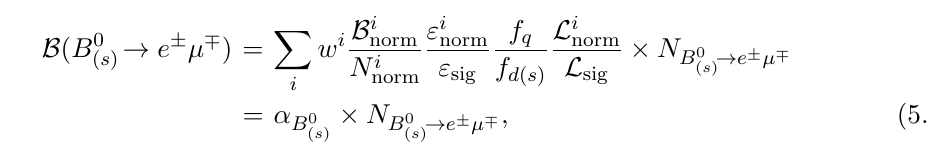
Figure 1 . Expected distribution of the BDT response for B 0 bremsstrahlung photons obtained from the B 0 ! K + (cid:25) (cid:0) control channel. The total uncertainty is shown as a light grey band. Each bin is normalised to its